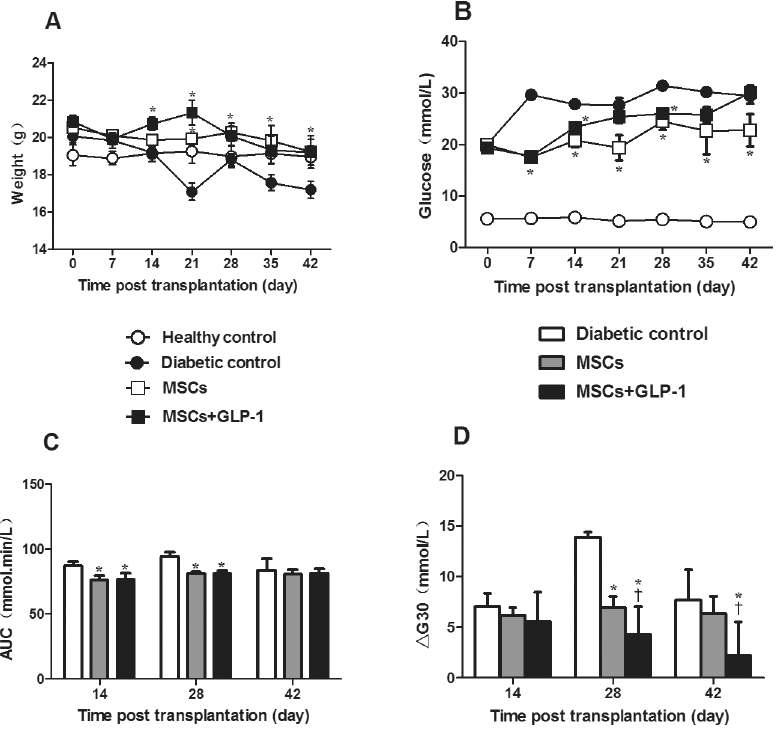
Figure 2. GLP-1 enhances MSC-mediated glucose tolerance in diabetic NOD mice. Following MSC infusion and GLP-1 treatment, the body weight and FGB levels of individual mice were measured weekly. The AUC and Δ G30 levels in individual mice at the indicated time points post treatment were determined. Data are expressed as the mean ± SEM of each group (n = 6 per group). (A) Body weight. (B) FBG levels. (C) AUC. (D) Plasma Δ G30 levels. * P < 0.05 versus diabetic controls. † P < 0.05 versus mice treated with MSCs alone. AUC: values of the area under the curve for the levels of blood glucose over the IPGTT period. Δ G30: net increase in the levels of blood glucose at 30 min post glucose